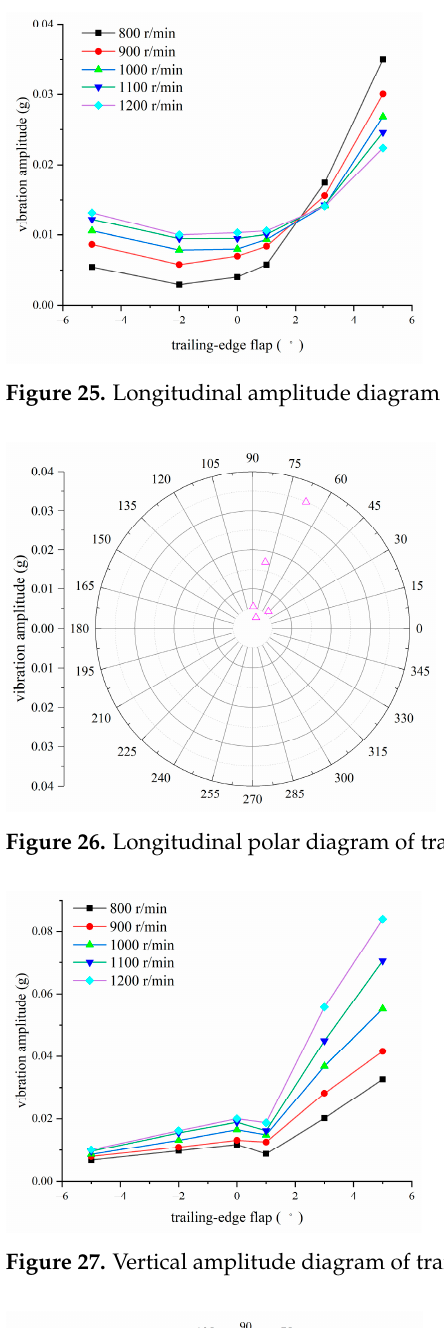
Figure 24. Lateral polar diagram of trailing-edge flap.